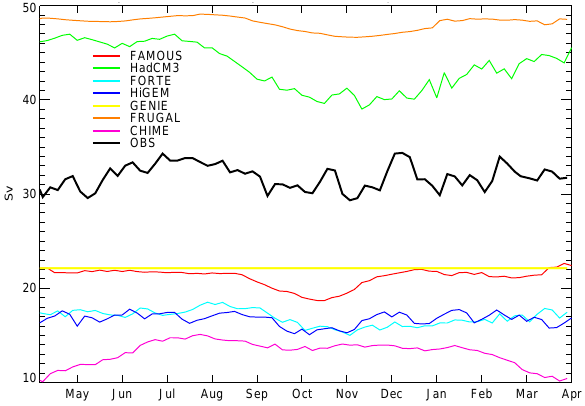
Fig. 6. Annual cycle of 5-daily western boundary current trans- port ( T GS ) at about 29 ◦ N calculated geographically (see Sect. 4 for Figure 6: Annual cycle of 5-daily Western Boundary Current ( T GS ) at about 29 o N calcu- details). lated geographically (See Sect. 4 for details).